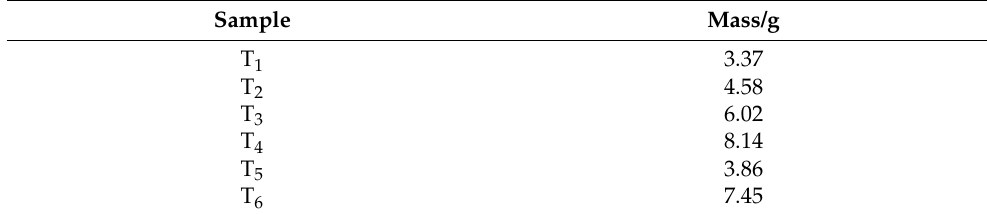
Table 5. Mass of copper mesh in sliding plate